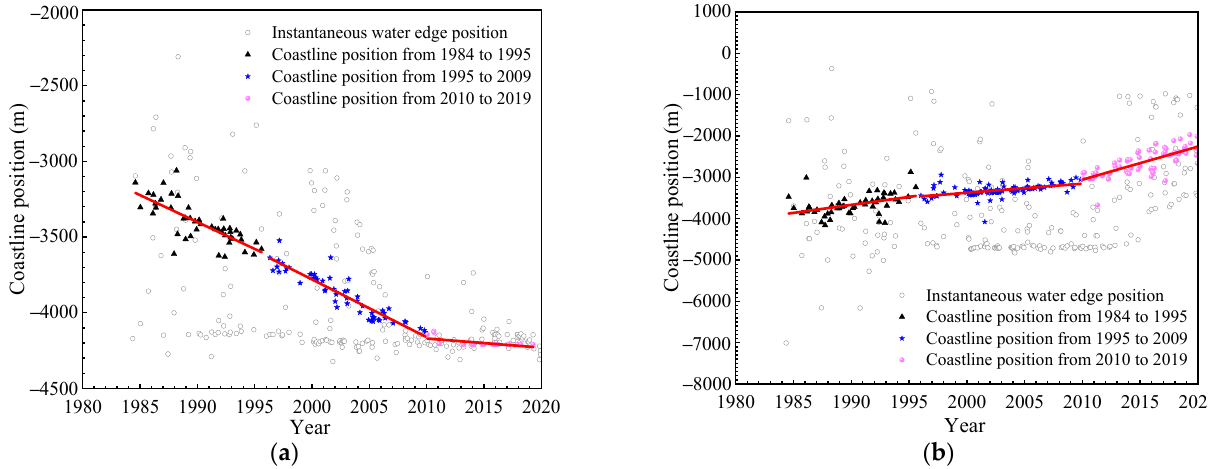
Figure 5. ( a ) The temporal changes of coastline position at the location of transect 235; ( b ) The temporal changes of coastline position at the location of transect 292.